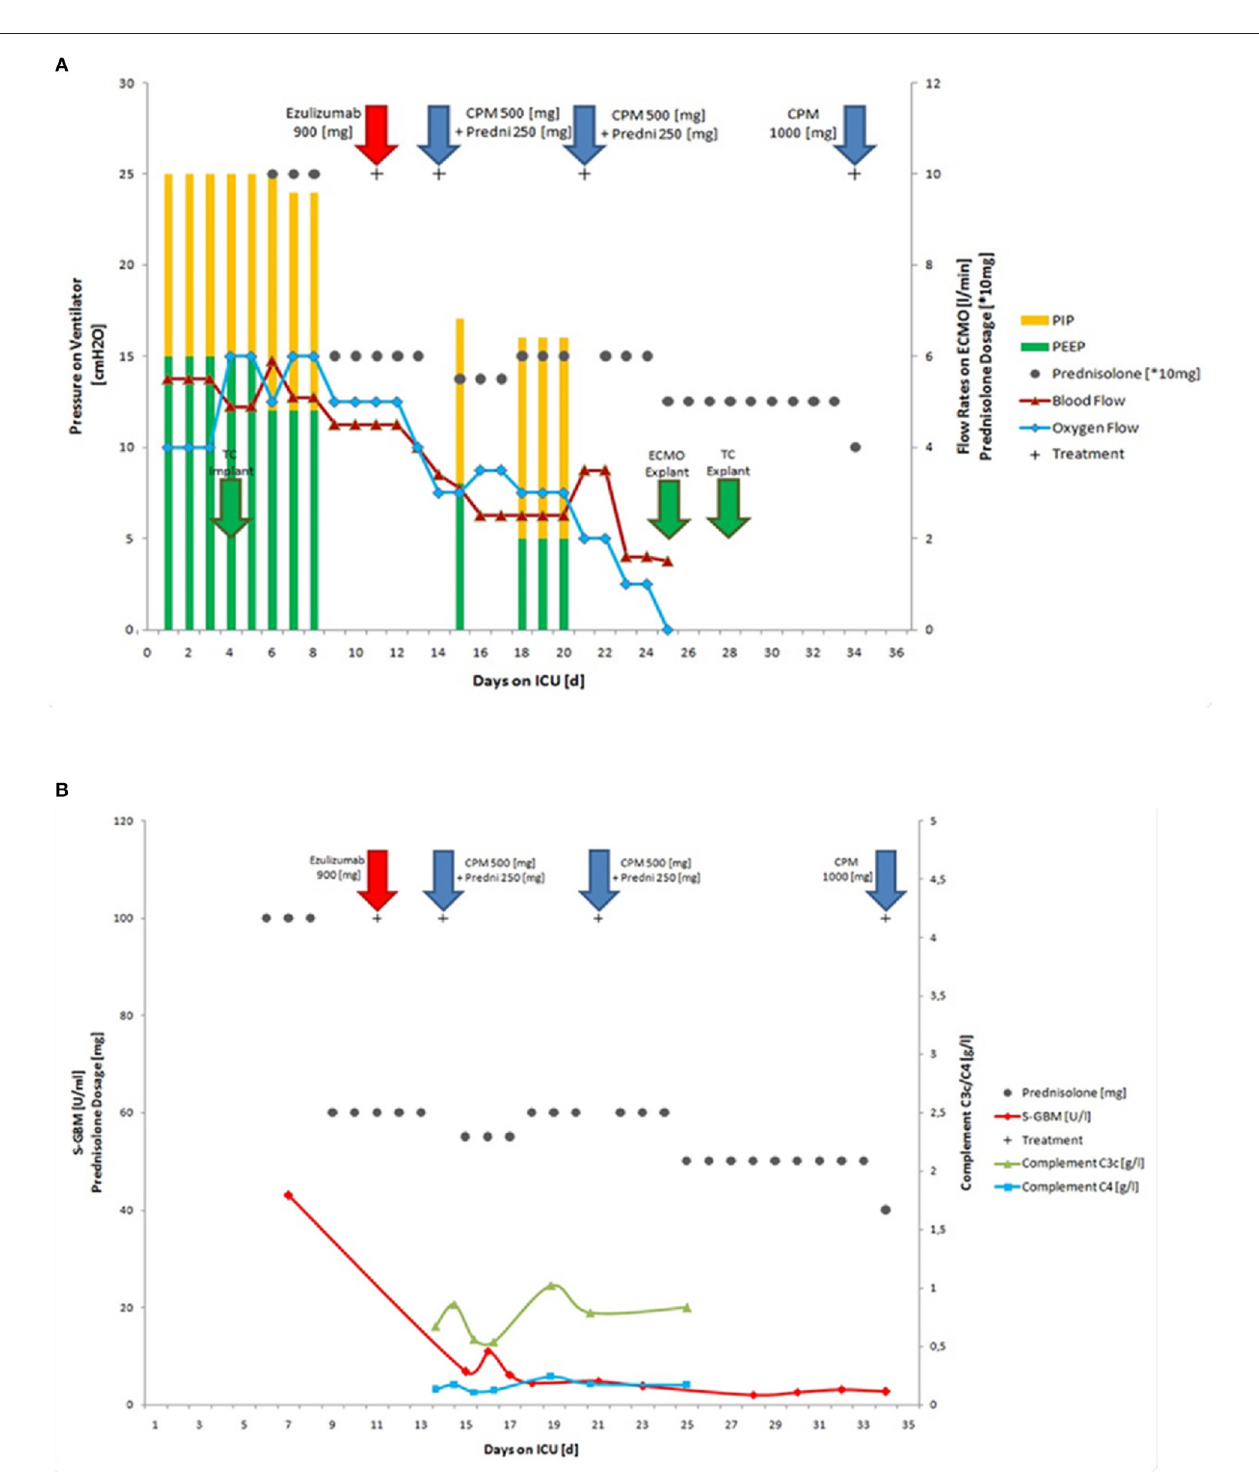
FIGURE 2 | Course of autoimmune disease during therapy. The 17-year old patient required intubation on the first day of hospital admission and also, a few hours later, ECMO therapy needed to be initiated on the first day of hospital admission. (A) ECMO and mechanical ventilation conditions during treatment in the ICU, including implantation and explantation of tracheal cannula (TC explant), PIP, PEEP, blood flow, oxygen flow and immunosuppressive therapy with Eculizumab, Cyclophosphamide, and Prednisolone; (B) Titers of anti-GBM and complement C3/C4 during therapy (normal ranges: S-GBM Elisa < 7 U/ml; C3 0.83–1.52 g/l; C4 0.13–0.37 g/l) ECMO, extracorporeal membrane oxygenation; TC, tracheal cannula; CPM, Cyclophosphamide; Predni, Prednisolone; PIP, positive inspiratory pressure; PEEP, positive end expiratory pressure; Explant, explantation.